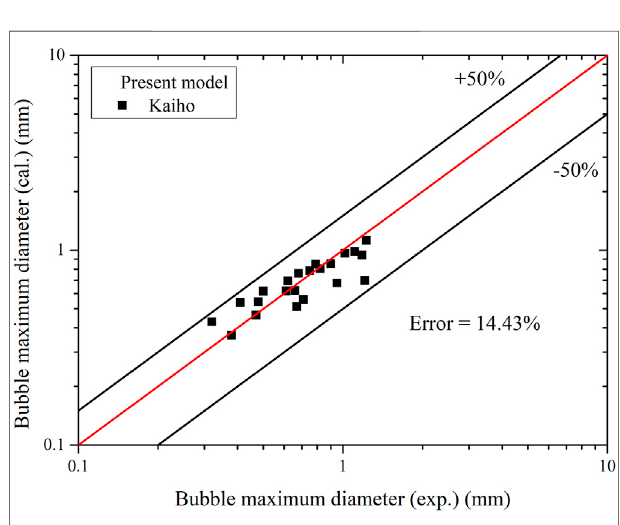
FIGURE 8 | Independent validation of present model for Kaiho ’ s